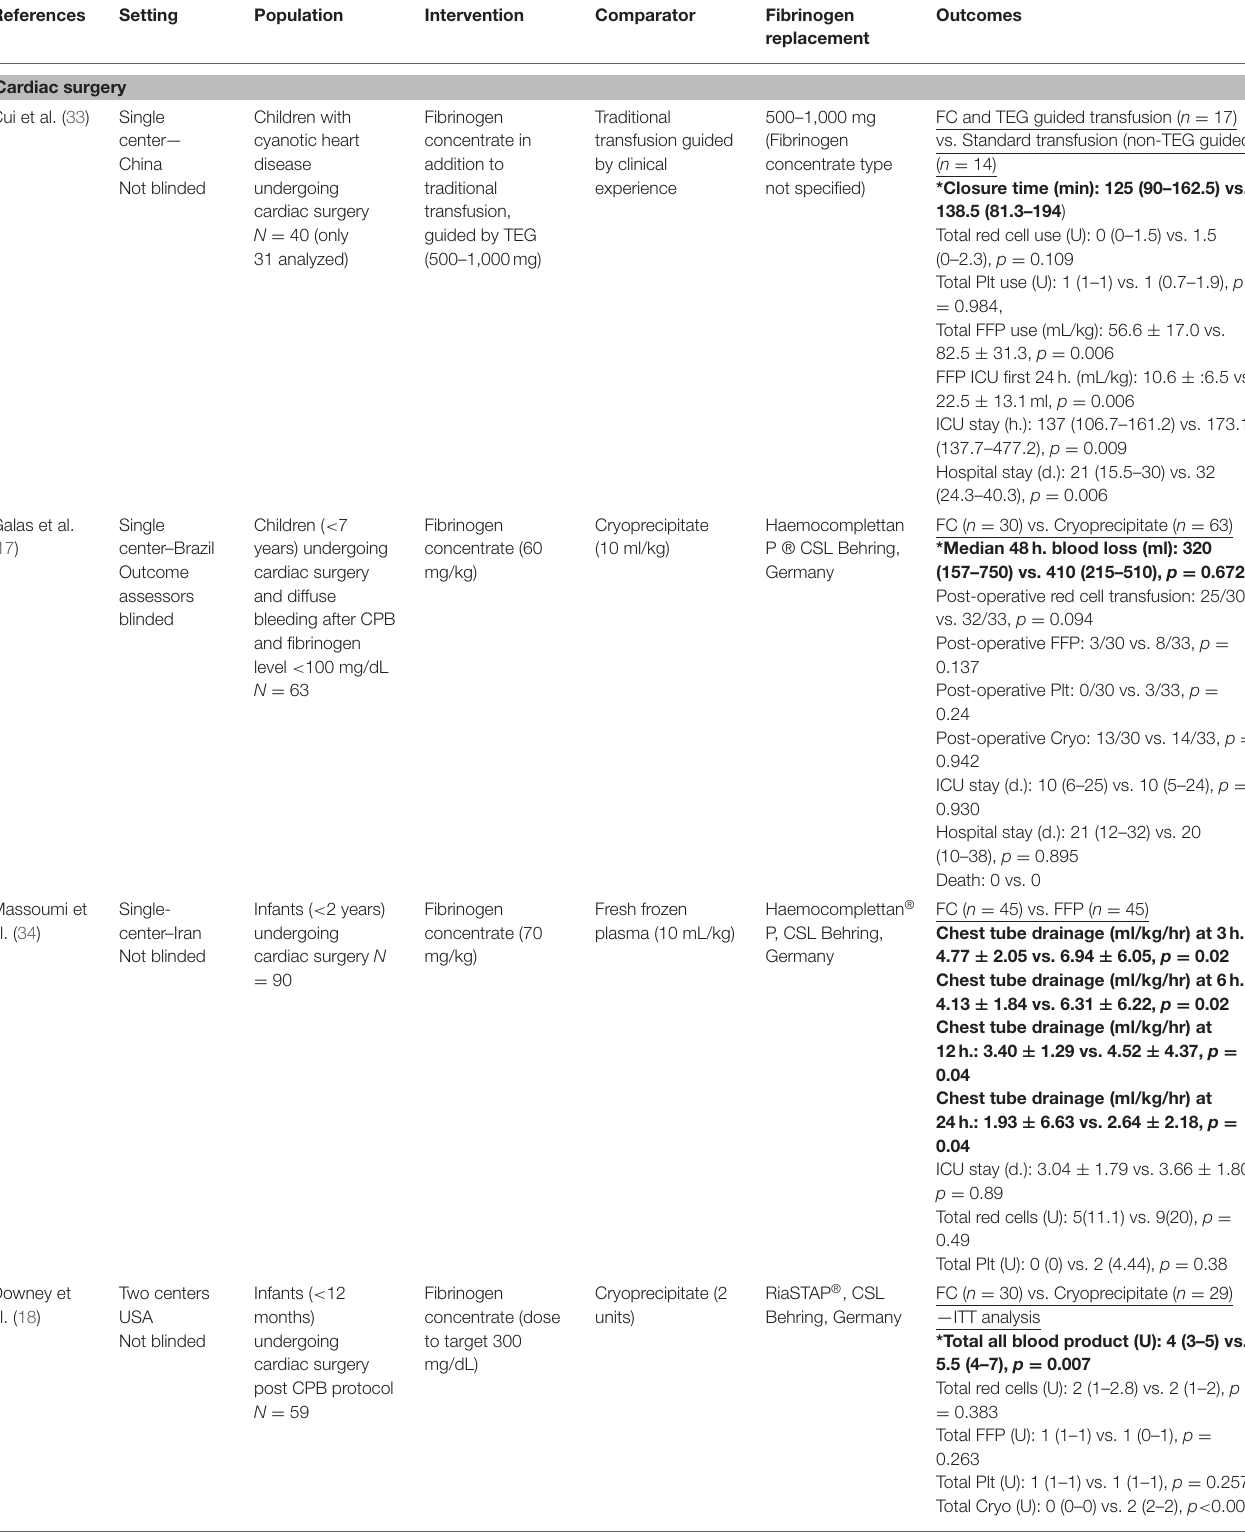
TABLE 2 | Randomized controlled trials of fibrinogen replacement in